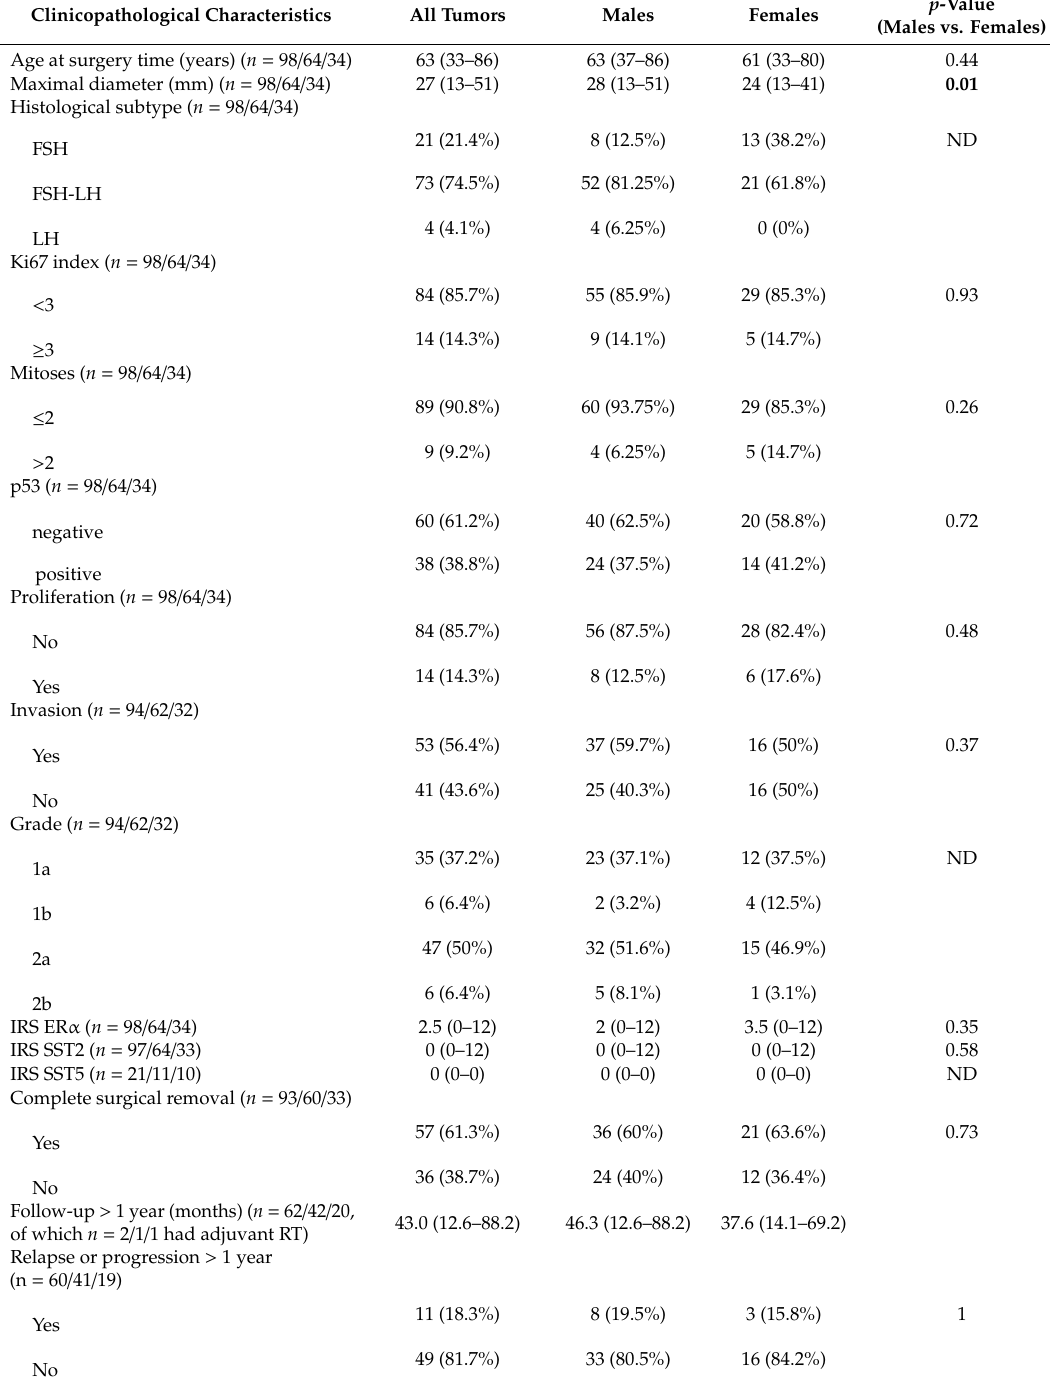
Table 1. Sex-related comparison of clinicopathological characteristics of the 98 gonadotroph tumors included in the